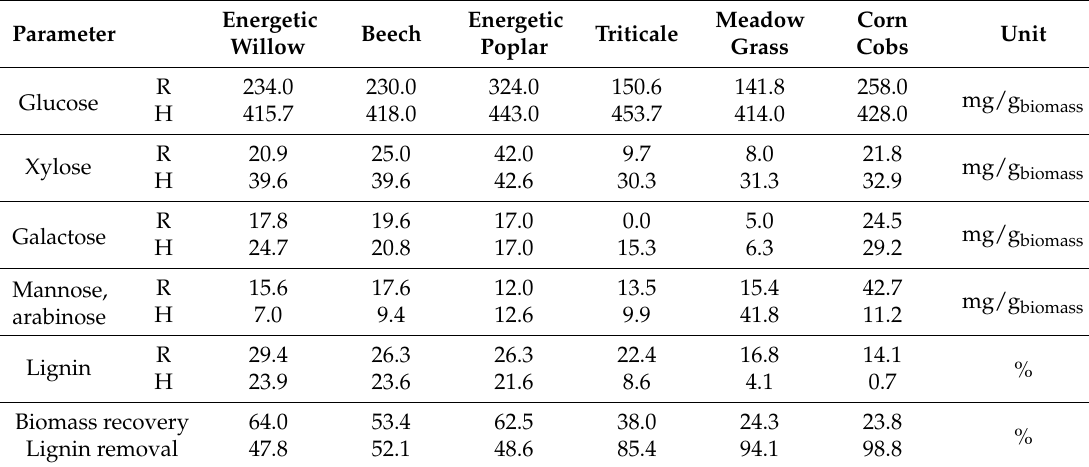
Table 9. Composition of enzymatic hydrolyzates obtained from raw (R) and alkaline pre-treated (H) biomass. Parameter